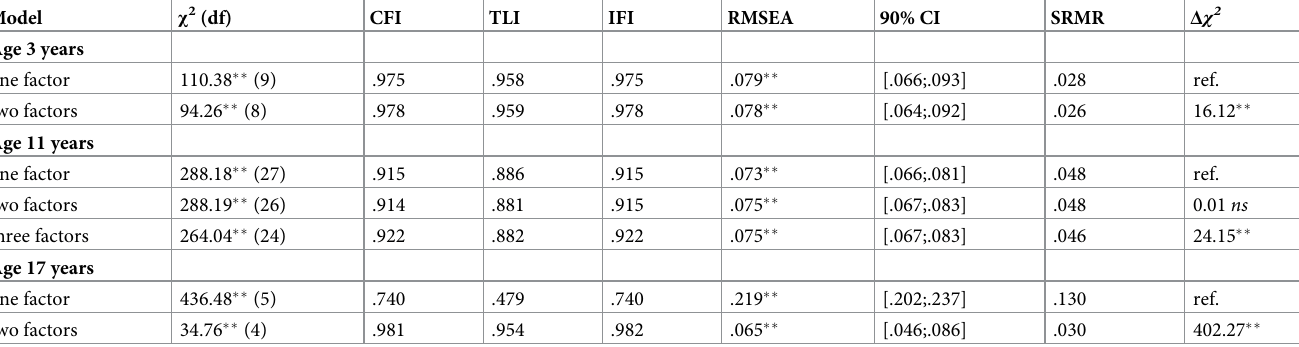
Table 1. Fit indices for confirmatory factor